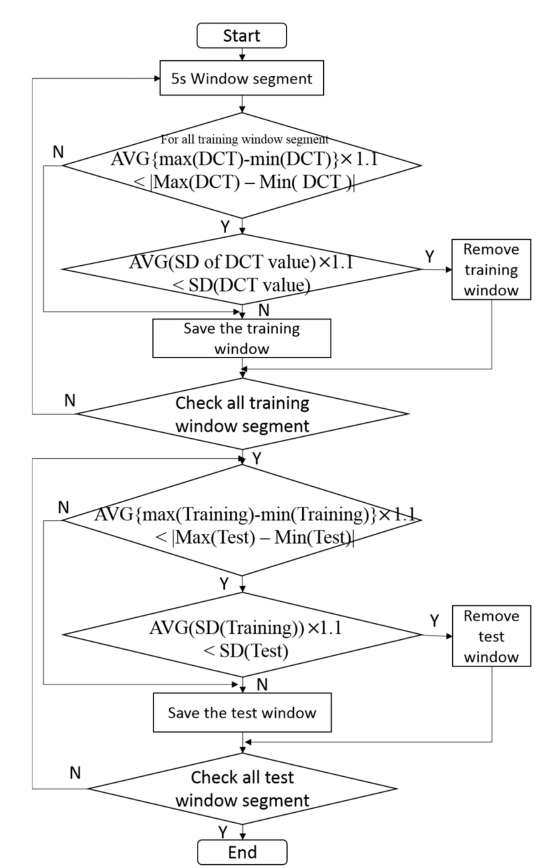
Figure 2. Flow chart of window removal method. SD: standard deviation; DCT: discrete cosine